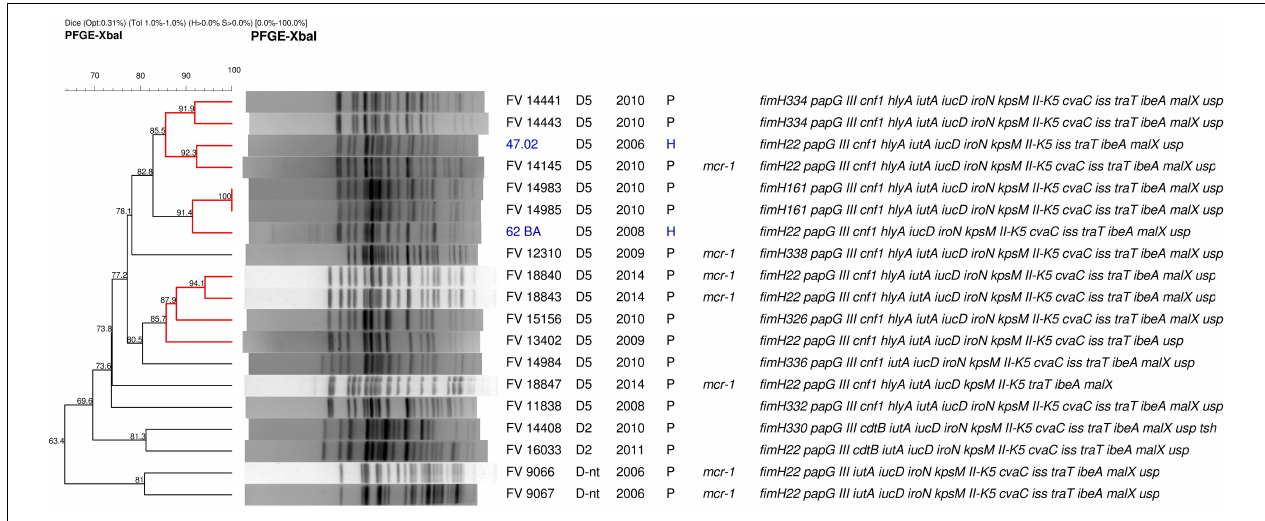
FIGURE 2 | PFGE macrorrestriction profile of 17 pig E. coli isolates belonging to the clonal group O25:H4-B2-ST131 (one ST131 isolate resulted autodigested) compared with two human clinical isolates of the LREC collection (showed in blue): association between isolation code, virotype, year, and origin of isolation (P, pig; H, human), mcr-1 presence, and virulence profile is indicated on the right. Highlighted in red clusters of similarity > 85%.